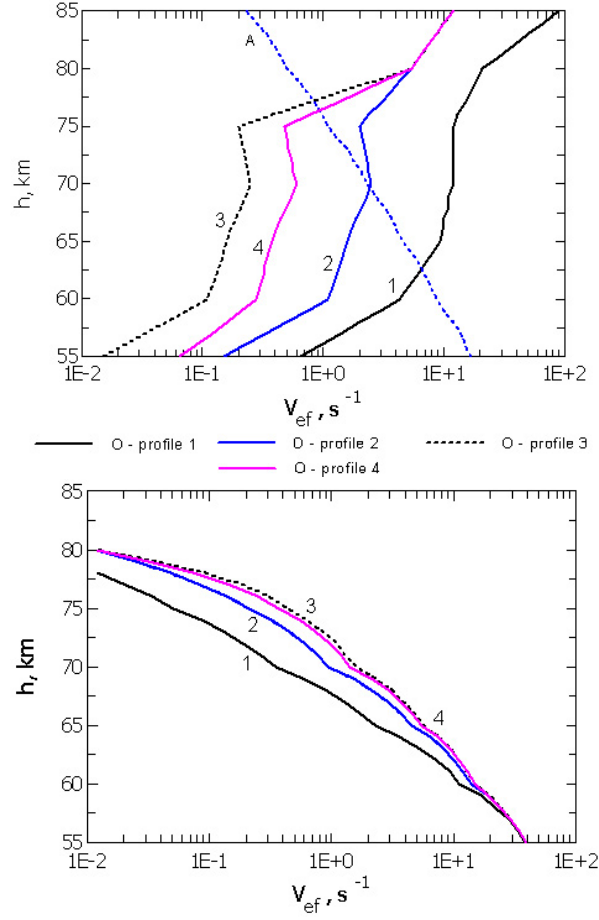
Fig. 2. Height profiles of reaction efficiencies. Upper panel: effi- ciencies of the reaction path forming hydrated ion clusters from O + 2 ion, The curves 1–4 are efficiencies of the reaction of O + ions with 4 atomic oxygen: O + +O → O + +O 3 , based on O-profiles 1–4. 4 2 Lower panel: curve A is the efficiency of hydrated ion formation O + (H 2 O) in the reaction: O + +H 2 O → O + (H 2 O)+O 2 . 2 4 2